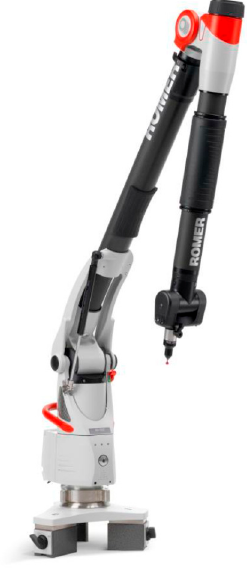
Table 3. Technical specifications of metrological 7-axis arm contact measurement, hexagon absolute arm 7325SI.